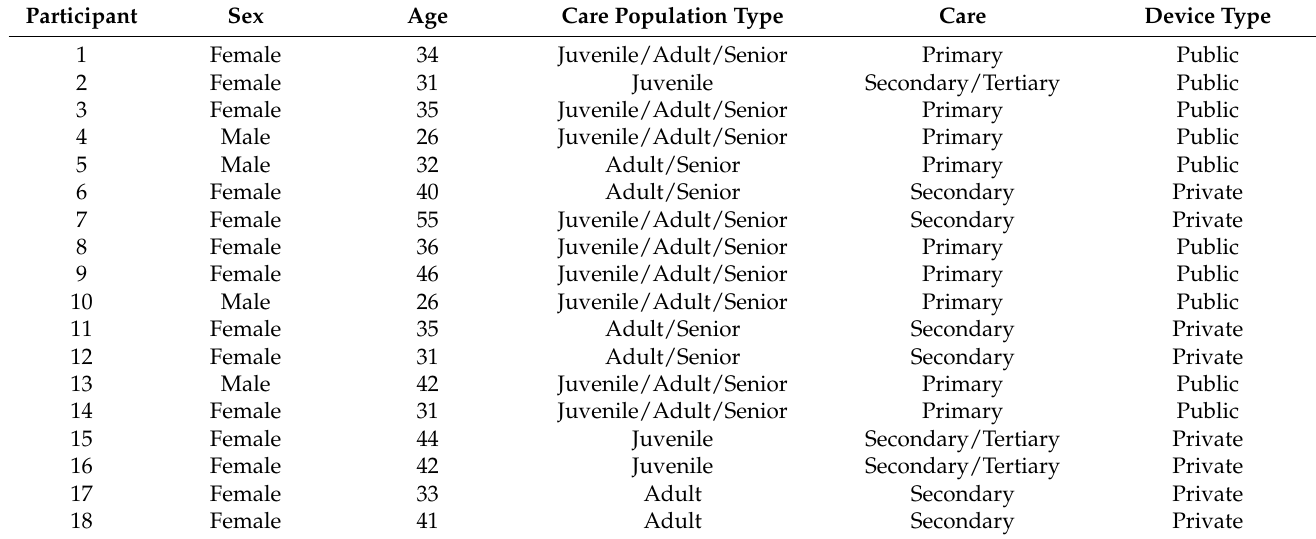
Table 1. Description of study participants.